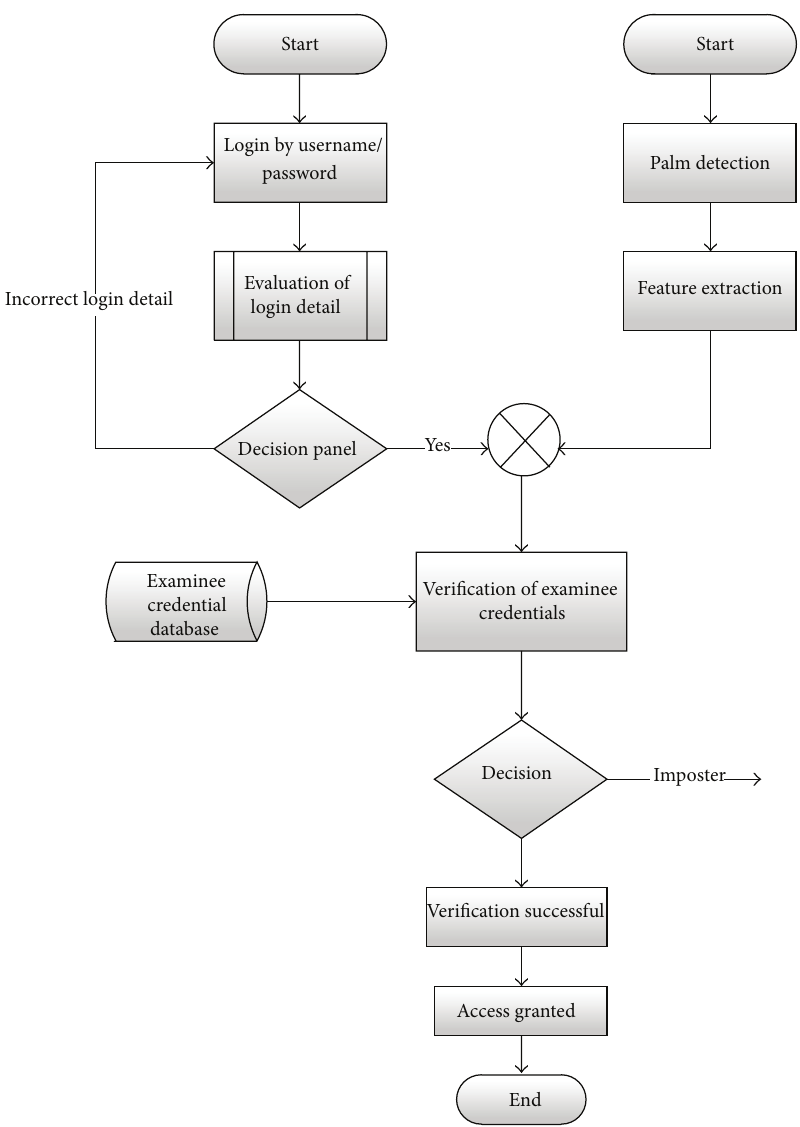
Figure 1: Proposed biometric authentication